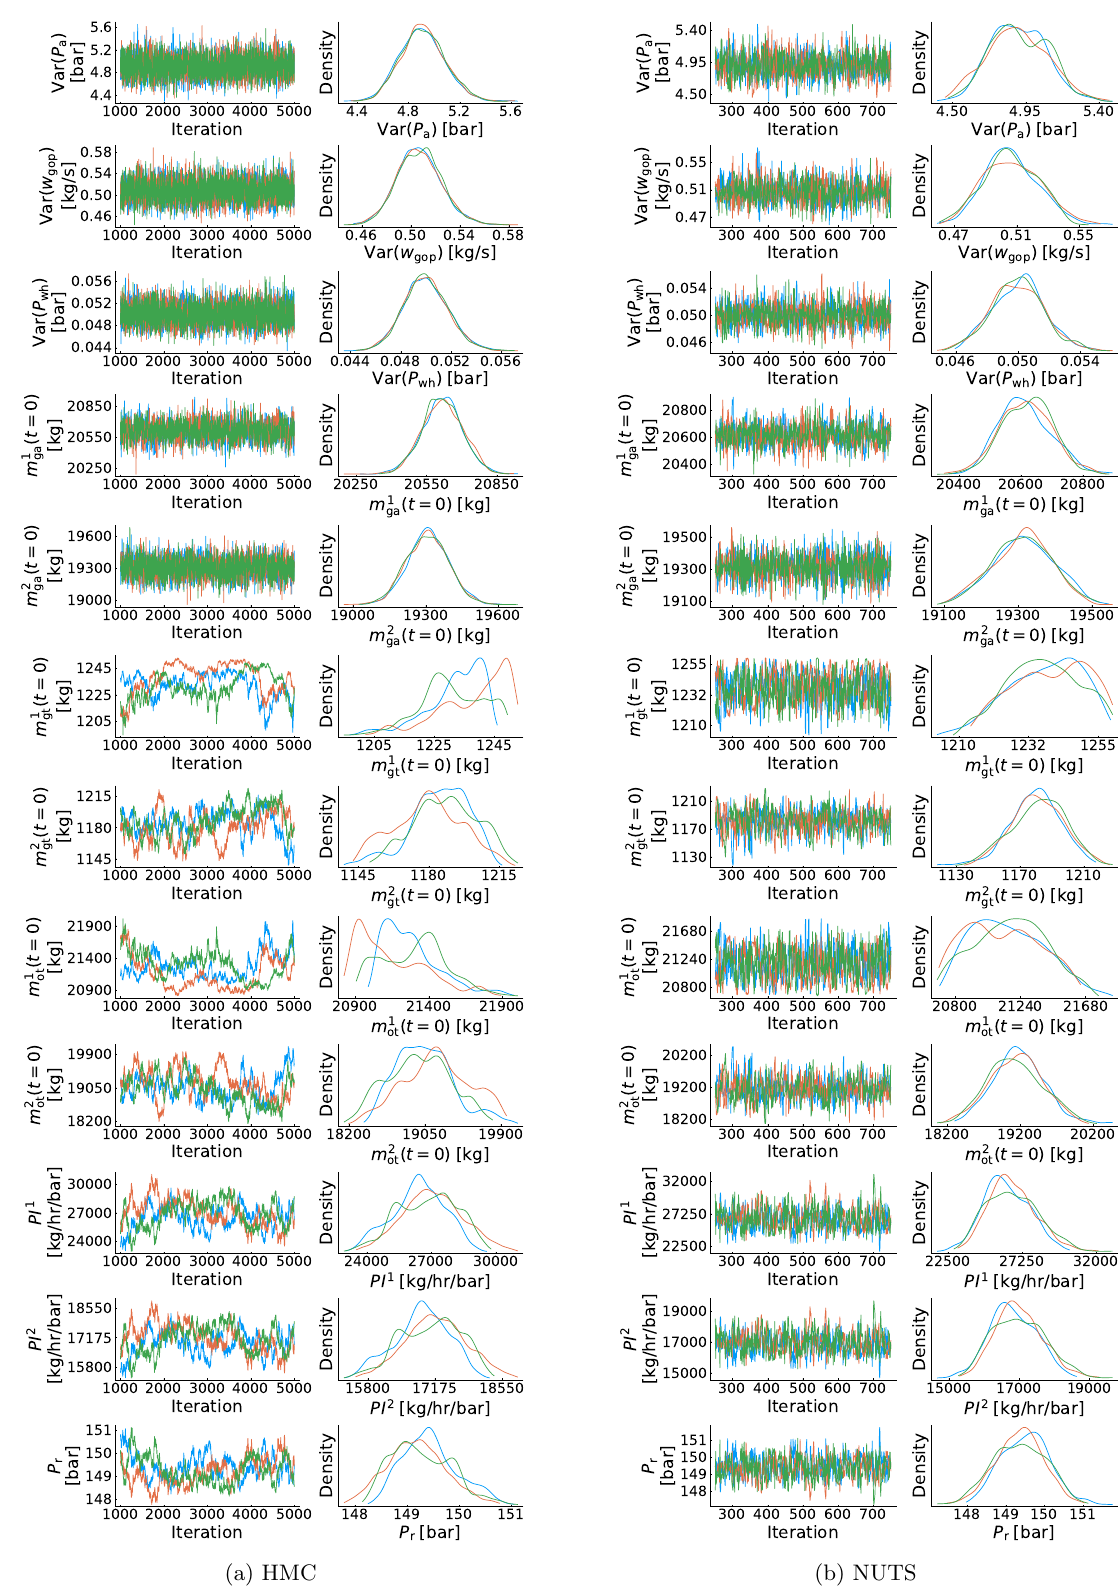
Figure 5: Trace plots and posterior PDFs. NOTE: The burn-in samples are not